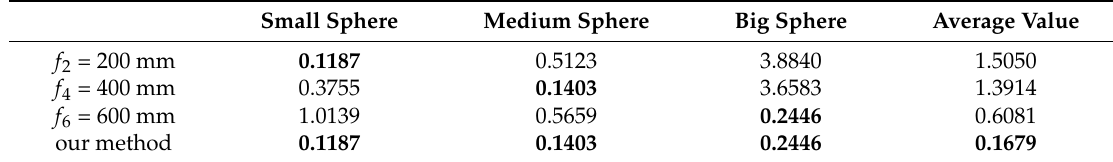
Table 3. Data comparison of fitting results in terms of mean error (mm).